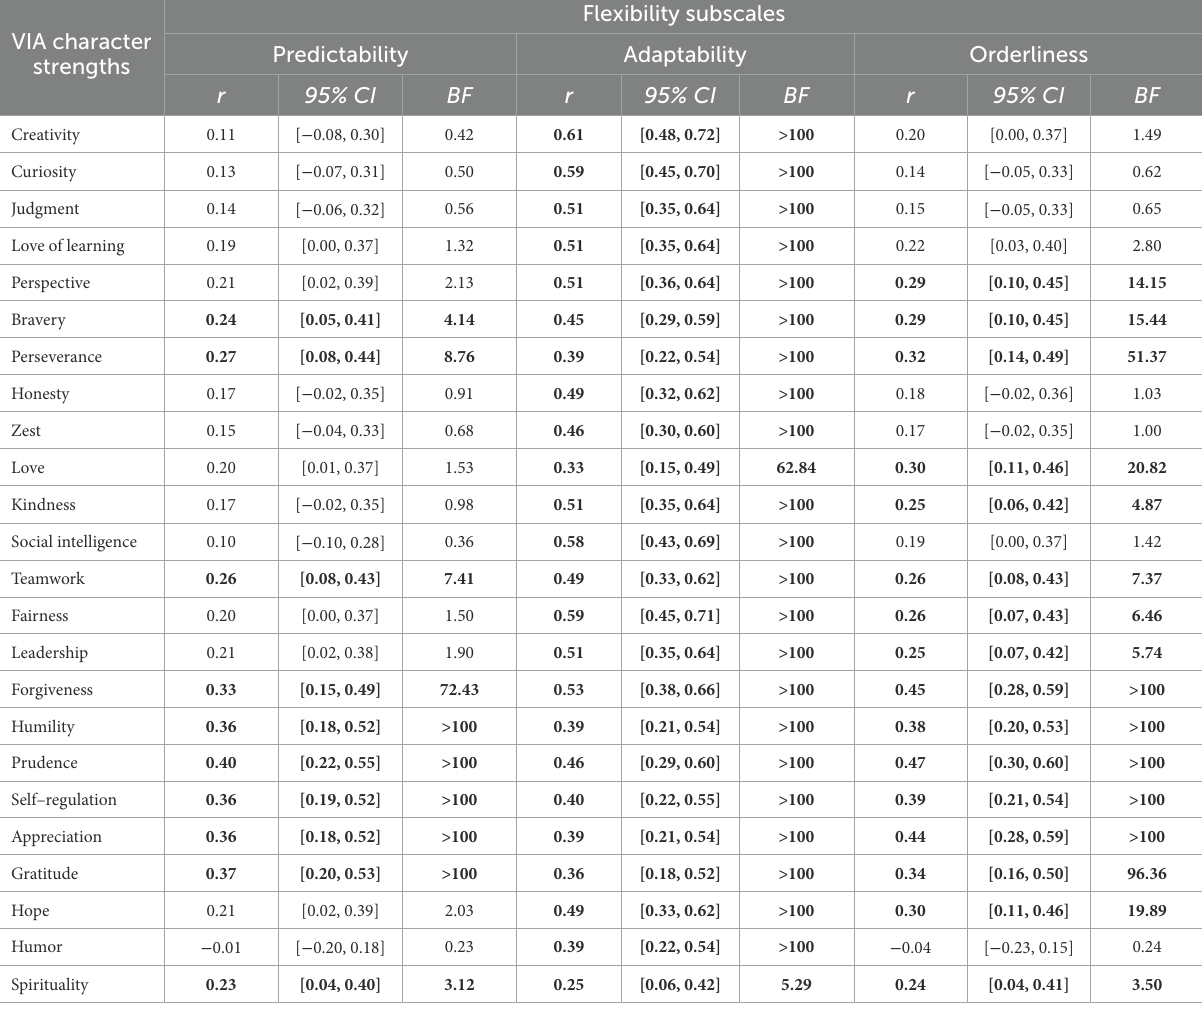
TABLE 3 Study 2: Pearson correlations between flexibility and VIA character strengths (daily